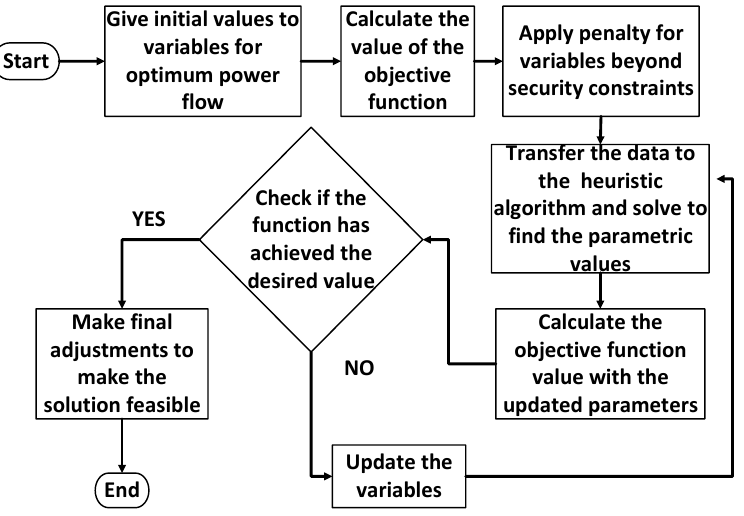
Figure 3. Power flow general algorithm.